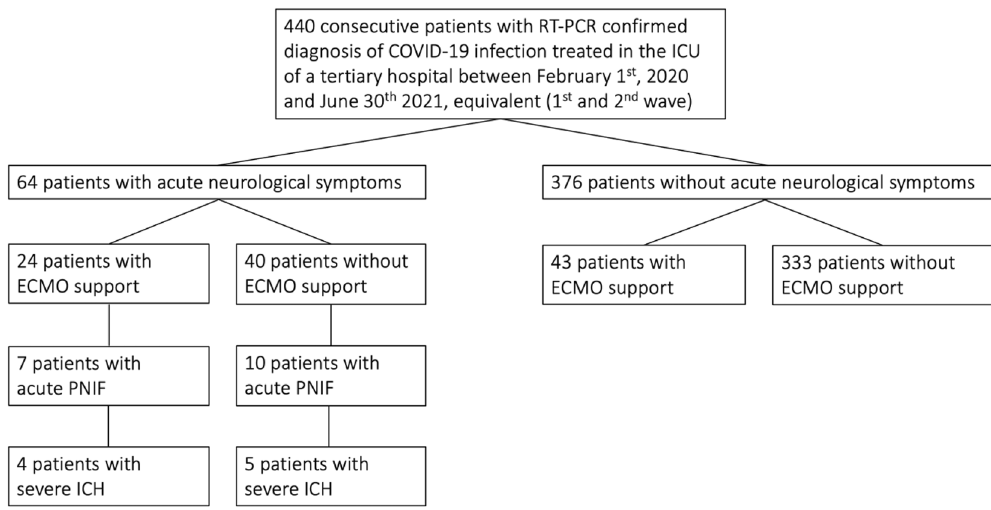
Figure 1. Flow chart of the patients included in the